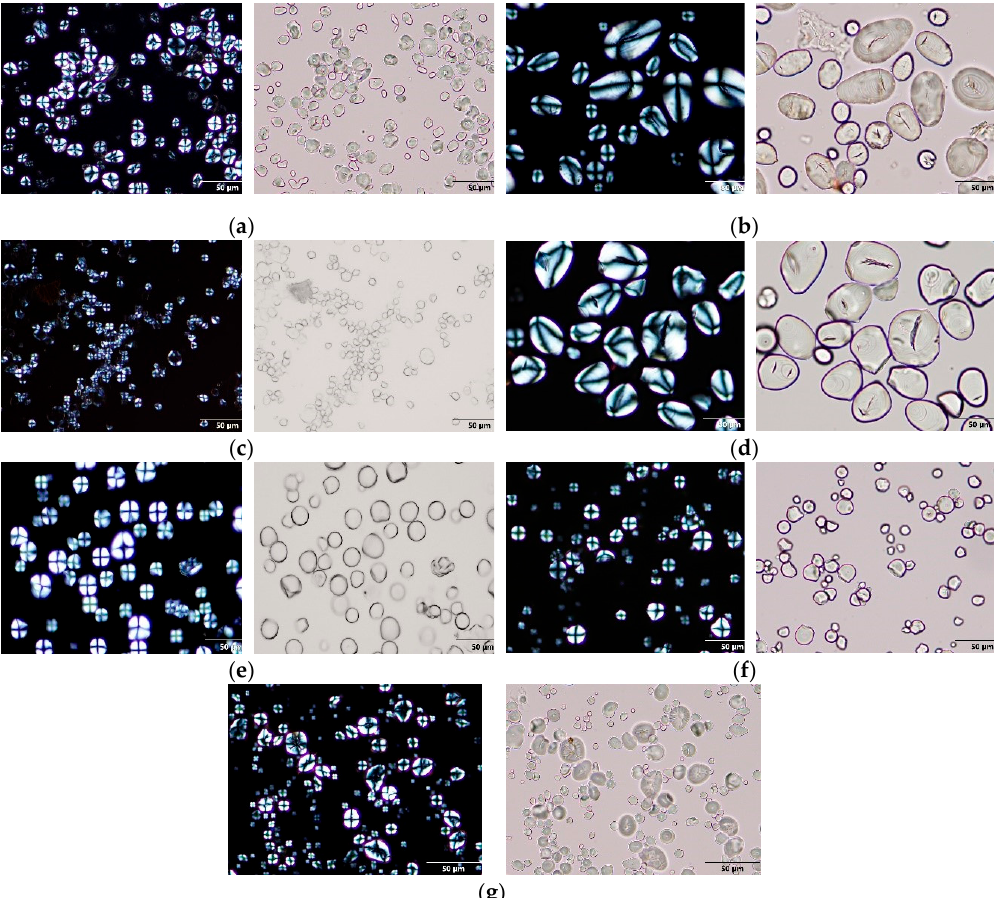
Figure 1. The microscope images of ( a ) HAMS, ( b ) KF, ( c ) RRF, ( d ) SGS, ( e ) SPS, ( f ) TS, and ( g ) WCS under normal and polarized light (40× objective). HAMS—high amylose maize starch, KF—kithul flour, RRF—red rice flour, SGS—sago starch, SPS—sweet potato starch, TS—tapioca starch and WCS—water chestnut starch. Table 2. The morphological properties of the starch and flours (data are means ± standard deviations).